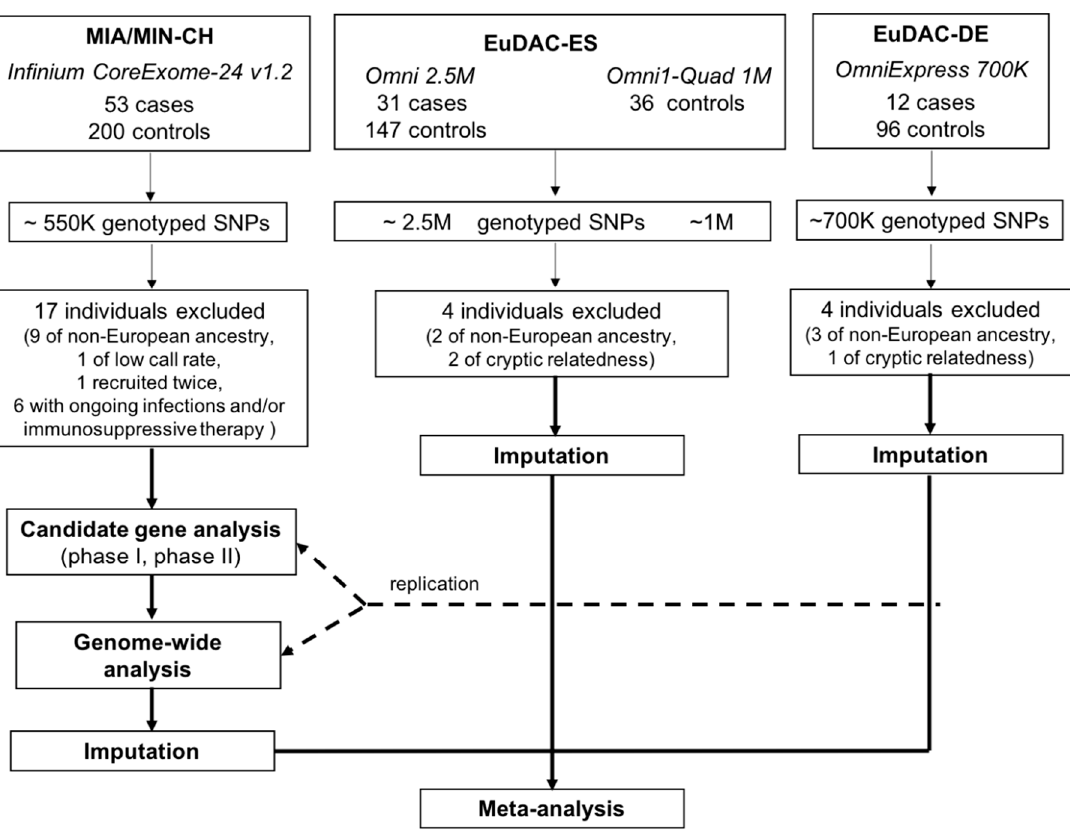
Figure 1. Study design . Cases and controls were genotyped separately using the indictaed Illumina arrays. MIA/MIN ‐ CH = Swiss cohort, EuDAC ‐ ES = Spanish cohort, EuDAC ‐ DE = German cohort, SNP = single nucleotide polymorphisms, K = 1000, M = 100,000.